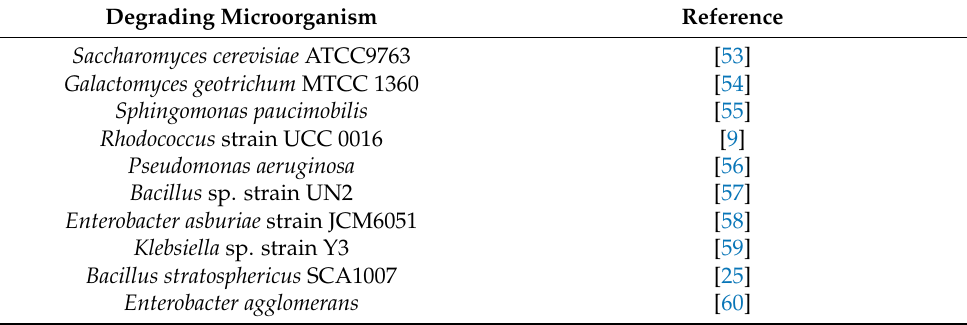
Table 3. Previously isolated microorganisms for degradation of Methyl